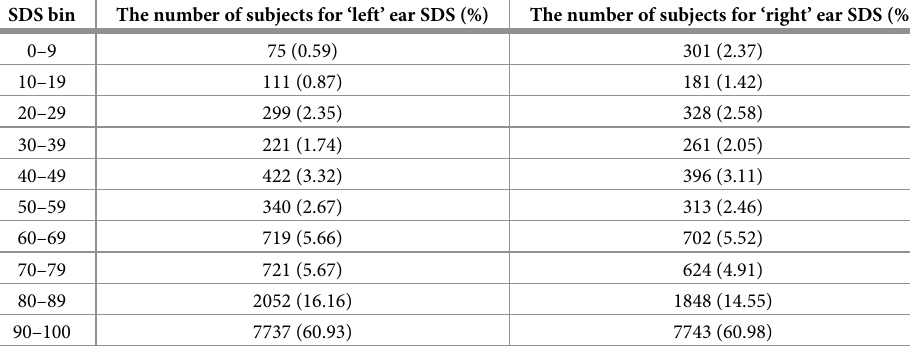
Table 1. The table of SDS bin distribution on 12,697